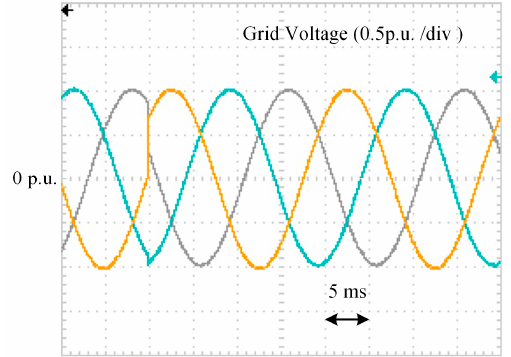
Figure 19. Grid voltages under + 40 ◦ phase jump